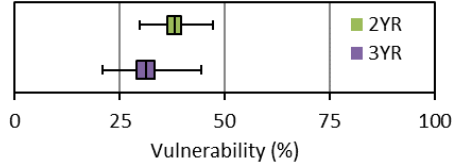
Figure 8. Box–whisker plots of the vulnerabilities of the 3YR (33000ha) and 2YR (50000ha) systems for typical values of in- take ratio (IR) and irrigation efficiency